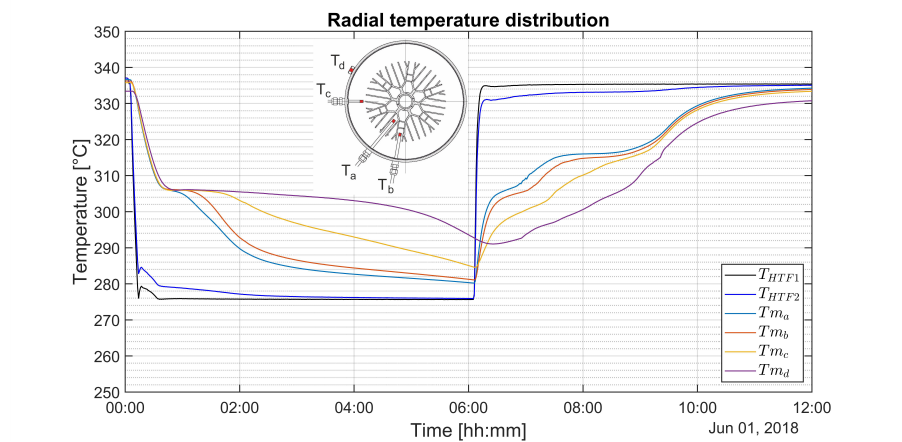
Figure 7. Radial temperature distribution in the PCM.